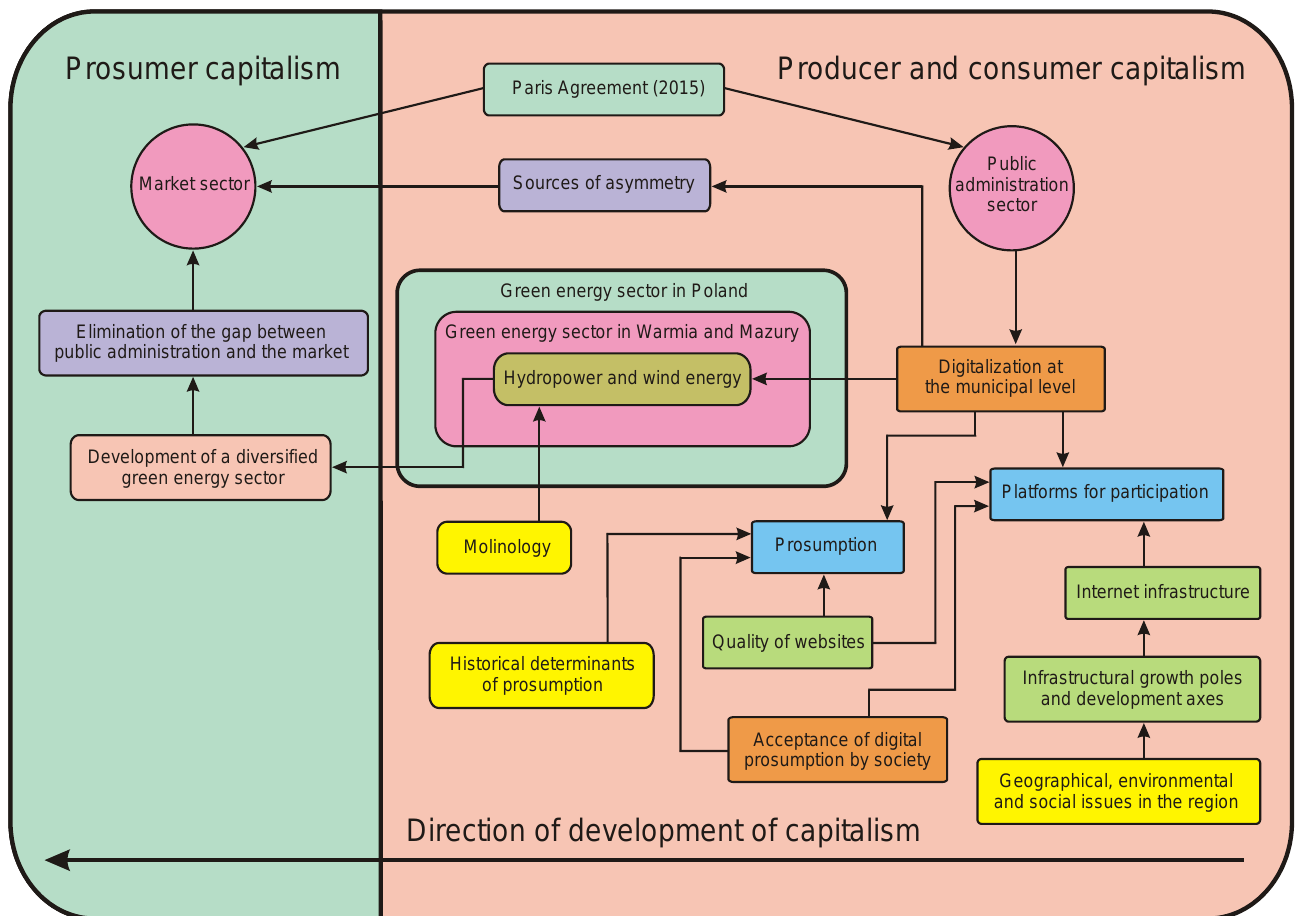
Figure 3. The first stage of research on the impact of citizens on the digitalization of municipal offices. Acceptance by the inhabitants of the Warmia and Mazury Province of digital prosumption in the local government sector was a prerequisite for the development of distributed generation.